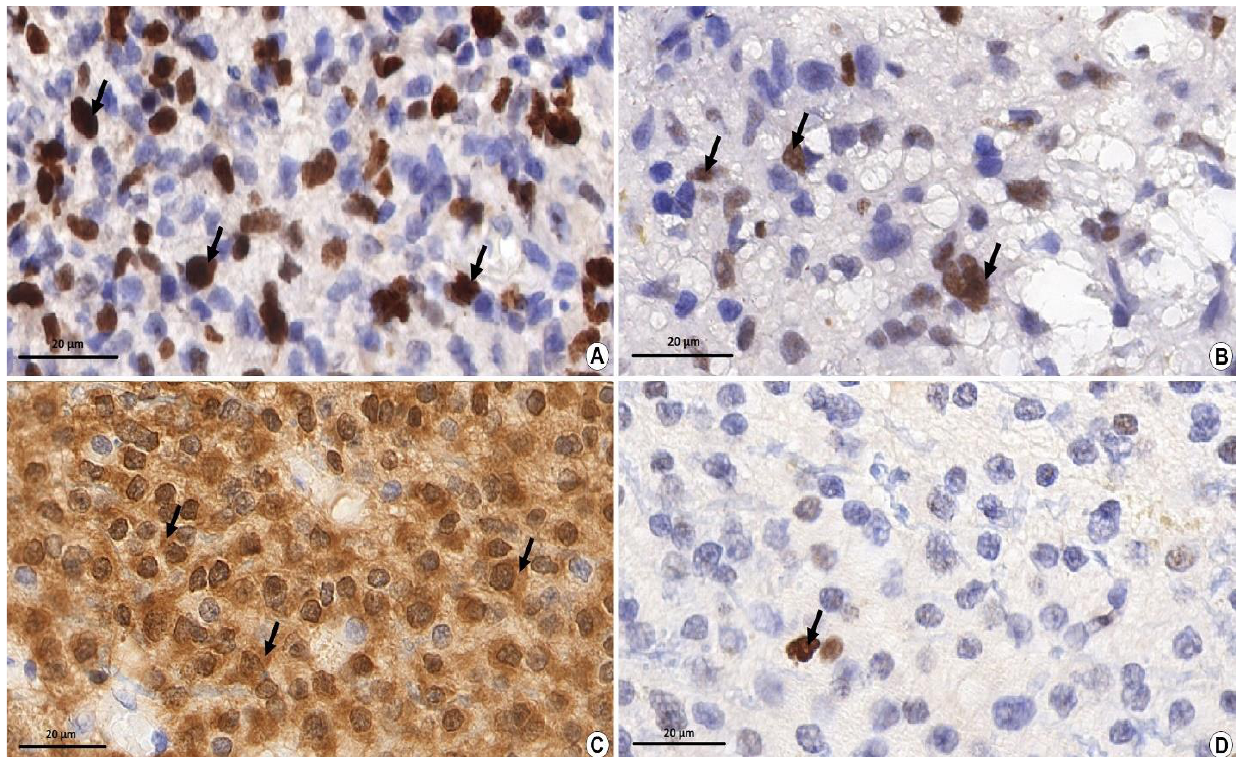
Figure 1. Immunohistochemical study of glial tumor markers. Magnification ×1000, Bar: 20 µm. ( А ) The level of nuclear non-histone protein — the marker of cell proliferation Ki-67 in the material of glioblastoma (grade IV). The diffusive pronounced nuclear brown staining (arrows) shows the bind- ing reaction of antigen – antibody (up to 50% of cells in hot spots) which indicates a high proliferation index of Ki-67. ( В ) The presence of a p53 marker in the fragment of the anaplastic astrocytoma (grade III). Diffusive, moderately pronounced nuclear staining (arrows) shows the antigen – antibody bind- ing reaction which indicates the presence of mutant protein p53. ( С ) The presence of an IDH1 mu- tation in the fragment of the diffusive astrocytoma (grade II). Diffusive, moderately pronounced brown staining in the cytoplasm shows the antigen – antibody binding reaction (arrows) which indi- cates the presence of an IDH1 mutation. ( D ) The presence of MGMT methylation in the material of the diffusive astrocytoma (grade II). Pinpoint (less than 10% of cells) nuclear brown staining (arrow) shows the antigen – antibody binding reaction which indicates the presence of methylation of the MGMT promoter.